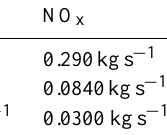
Table 2. Outputs from GEOS-Chem-TOMAS used as inputs for SAM-TOMAS. The fully resolved aerosol size distribution from GEOS-Chem-TOMAS was used in SAM-TOMAS, but for concise- ness we only tabulate the condensation sink here. Cases where the DSWRF was less than 100 were excluded from this study because of uncertainties associated with OH production for these conditions.